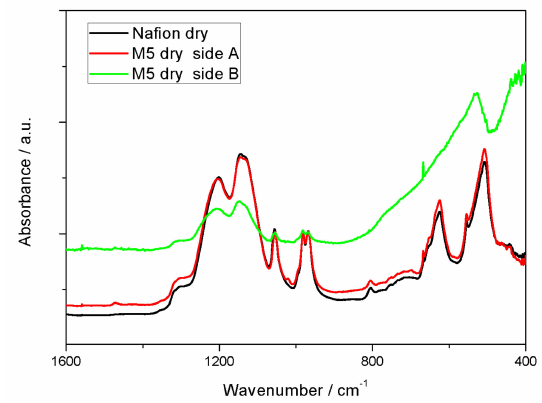
Figure 3. FTIR Spectra of a dry Nafion membrane (black) and a dry M5 membrane when facing side A (red) or side B (green) towards the ATR crystal.